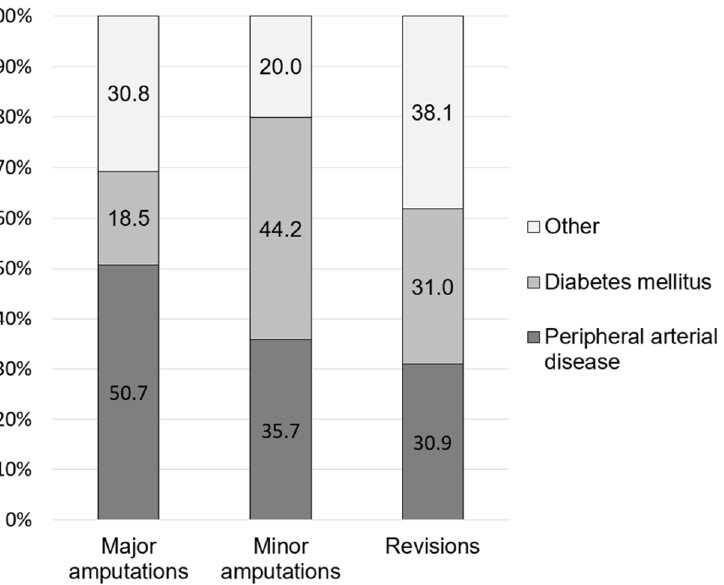
Figure 2. Main diagnoses of patients undergoing major amputations, minor amputations, and revision surgeries of an amputation site in 2019.